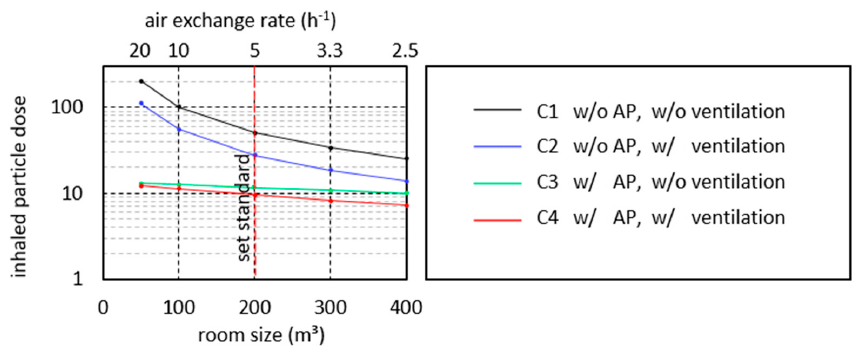
Figure 9. Effect diagram of the room size in logarithmic scale. The other influence parameters are kept at their set standard value in Table 4. The room size is 200 m 3 , the volumetric flow of the AP is 1000 m 3 /h.